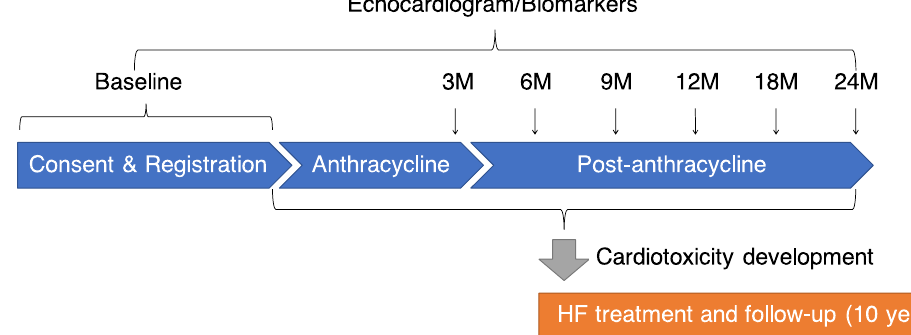
Figure 1. Flow chart of study. HF: heart failure, M: month.